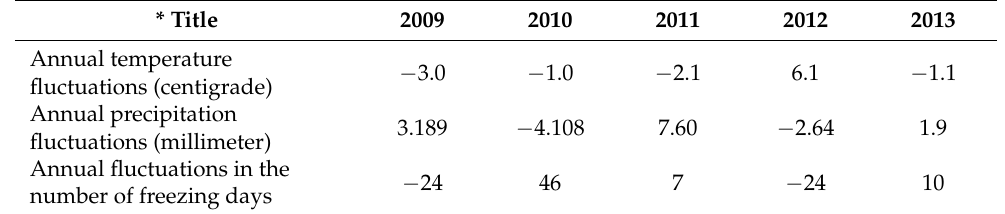
Table 2. The rate of heat increase severe rainfall and freezing. The average of the five-year period